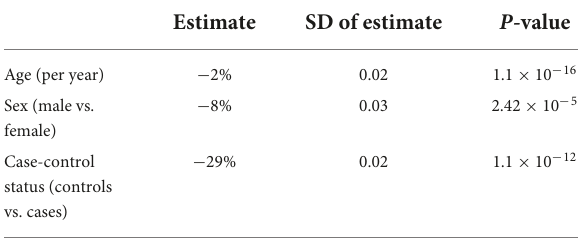
vs. 0.012% per year, p < 0.0001) and also arguing against the